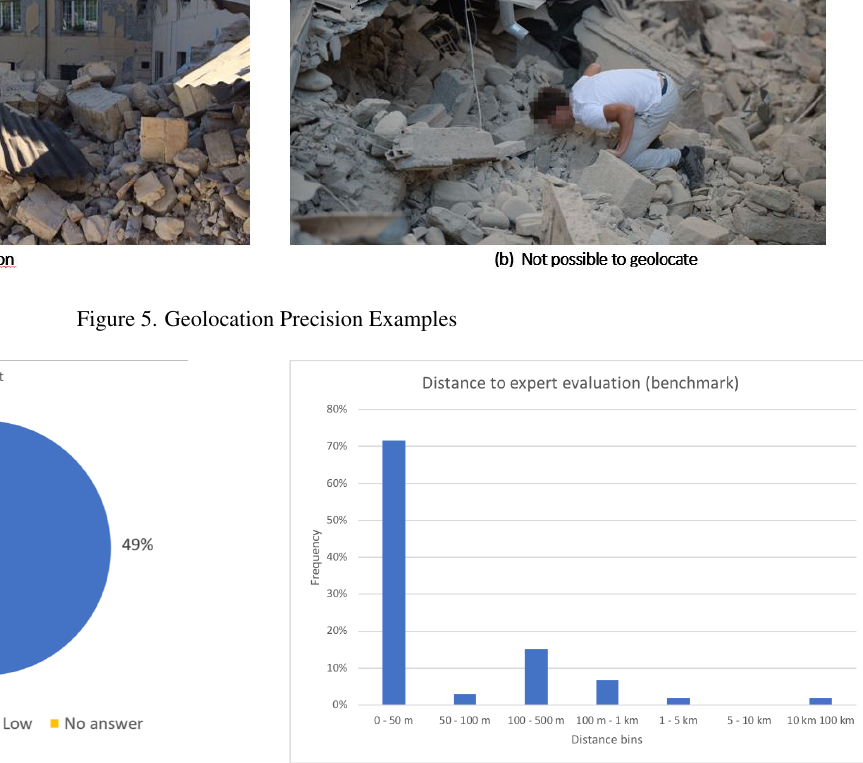
Figure 6. Expert Precision